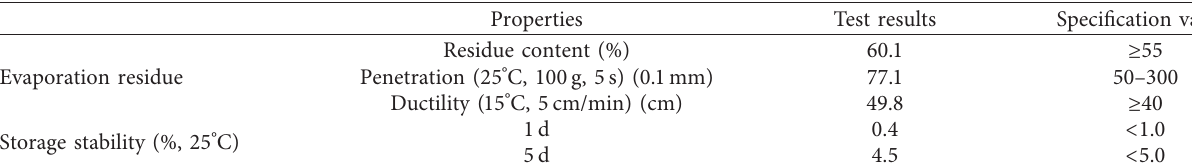
Table 2: Properties of emulsified asphalt.